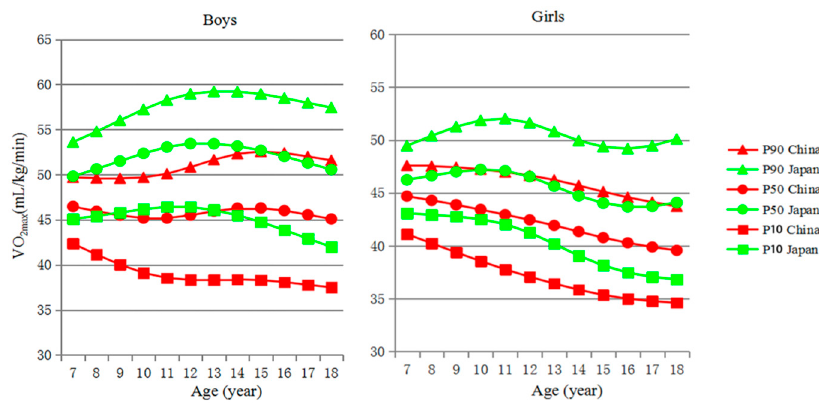
Figure 1. Centile curves for 20mSRT performances of Chinese and Japanese children and adolescents aged 7–18 years.